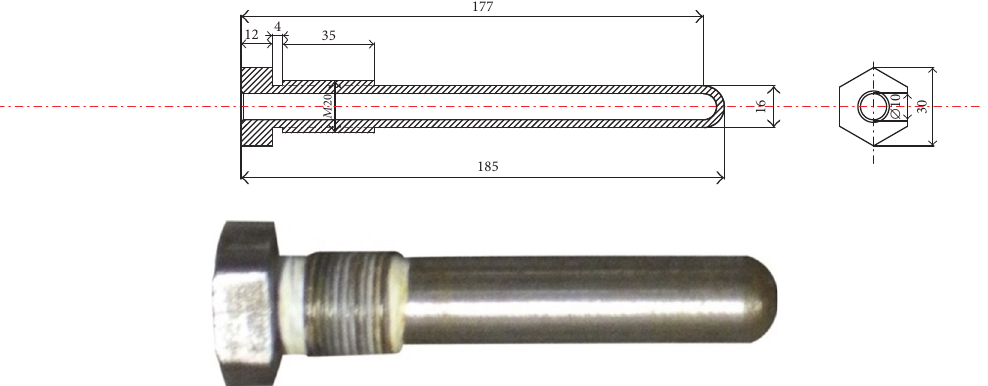
Figure 4: Schematic view of protective sleeve.